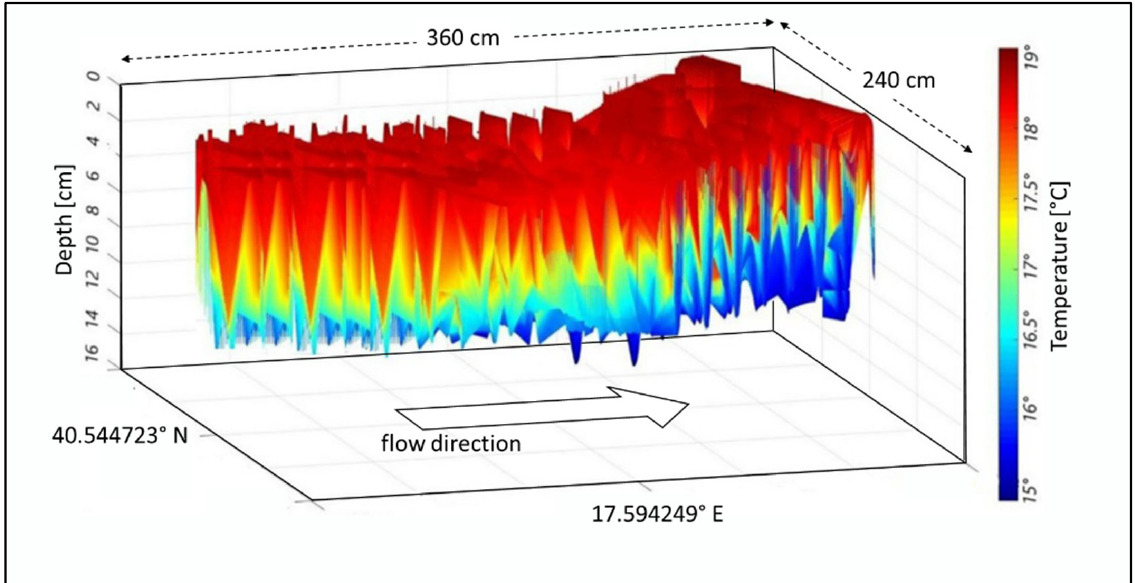
Figure 7. Temperature values, retrieved using the beamforming-based technique vs. depth and GPS references for cross-section A.